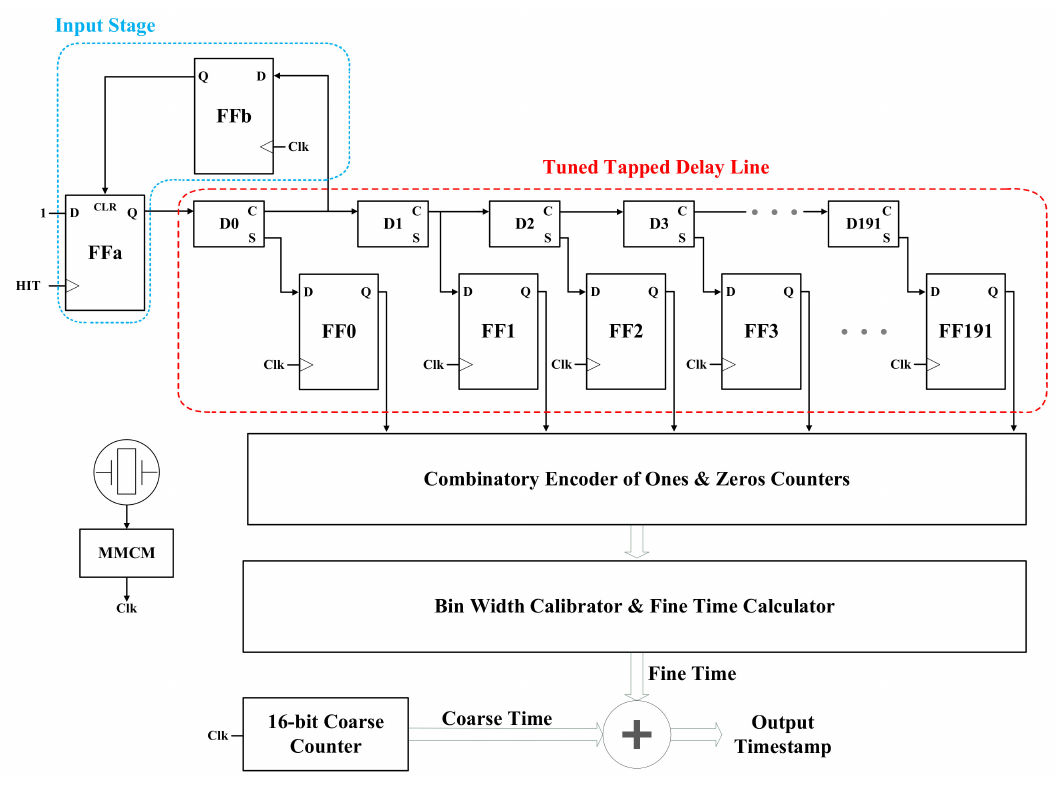
Figure 1. Architecture of the proposed FPGA-based TDC.